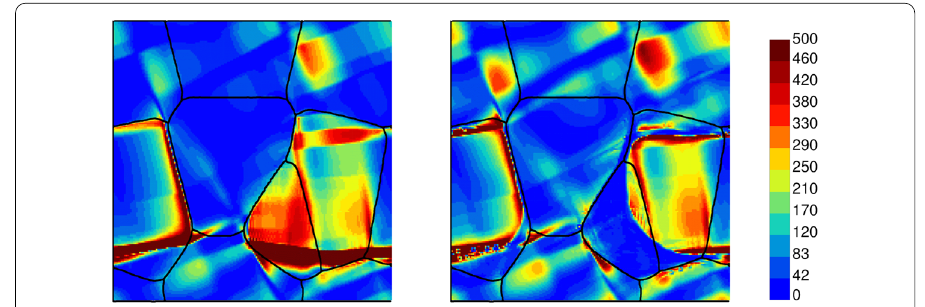
Fig. 9 The scalar dislocation density ρ with only one active slip systems just after deformation has been applied (left) and 2h later (right). The maximum display value for ρ has been set to 5 · 10 14 m − 2 (the scale of the colorbar is in µ m − 2 ) in order to more clearly demonstrate how it is distributed over the grains. The true maximum value is 2 . 4 · 10 15 m −